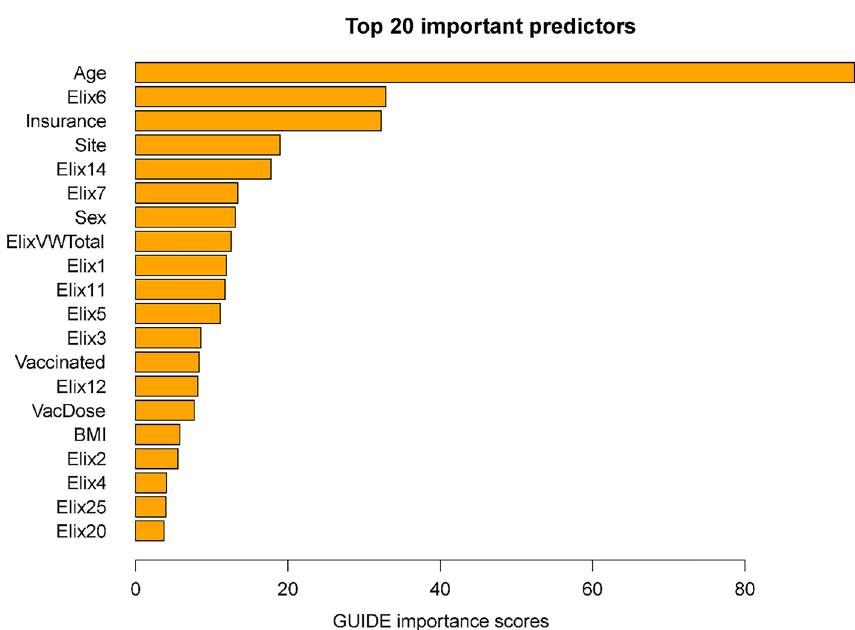
Figure 5. Twenty most important variables and their GUIDE importance scores for predicting Mortality from Subsample. Elix6 hypertension, uncomplicated, Elix14 renal failure, Elix7 Hypertension, complicated, ElixVWTotal weighted comorbidity total score, Elix1 congestive heart failure, Elix11 diabetes, uncomplicated, Elix5 peripheral vascular disorders, Elix3 valvular diseases, Vaccinated any vaccine dose (vs. none), Elix12 diabetes, complicated, VacDose number of vaccine doses, Elix2 cardiac arrhythmias, Elix4 pulmonary circuation disorders, Elix25 fluid and electrolyte disorders, Elix20 solid tumor without